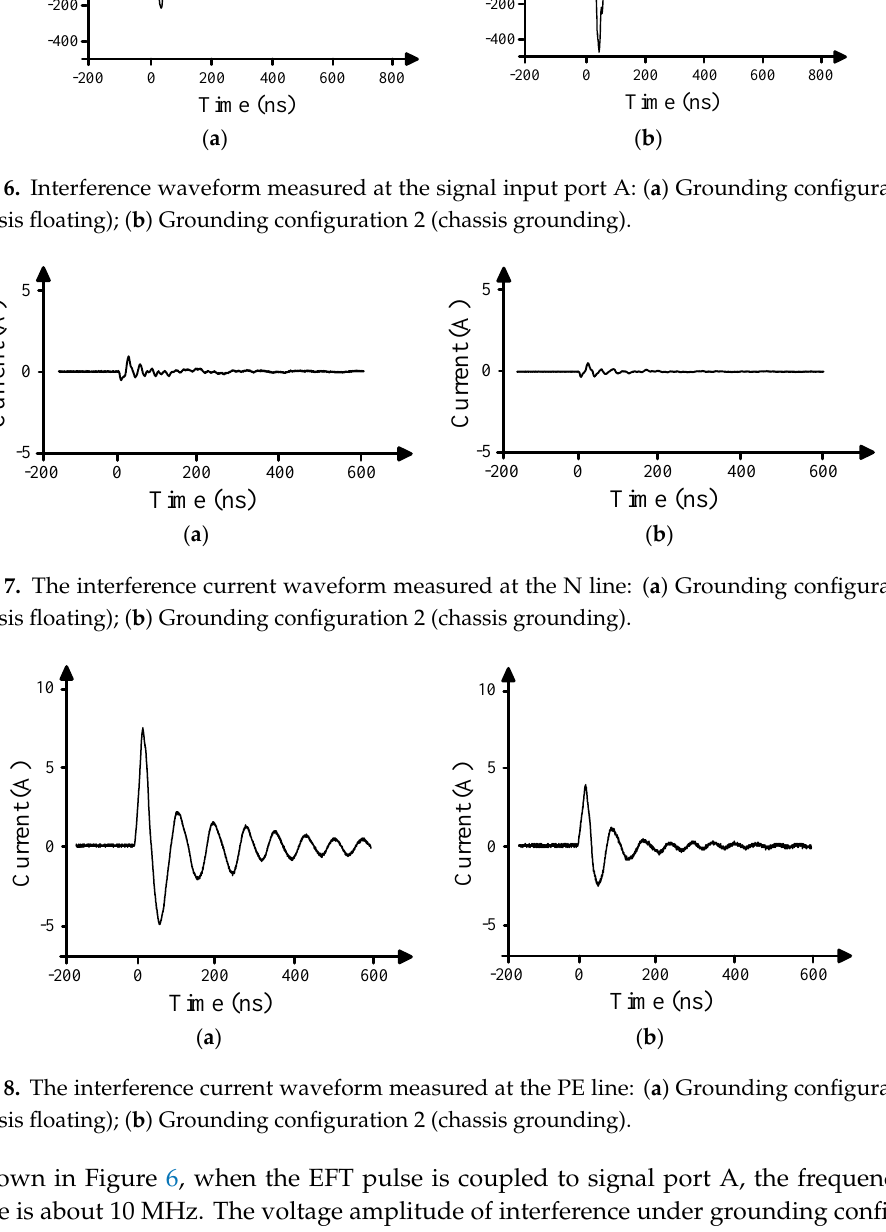
Figure 8. The interference current waveform measured at the PE line: ( a ) Grounding configuration 1 (chassis floating). ( b ) Grounding configuration 2 (chassis grounding).